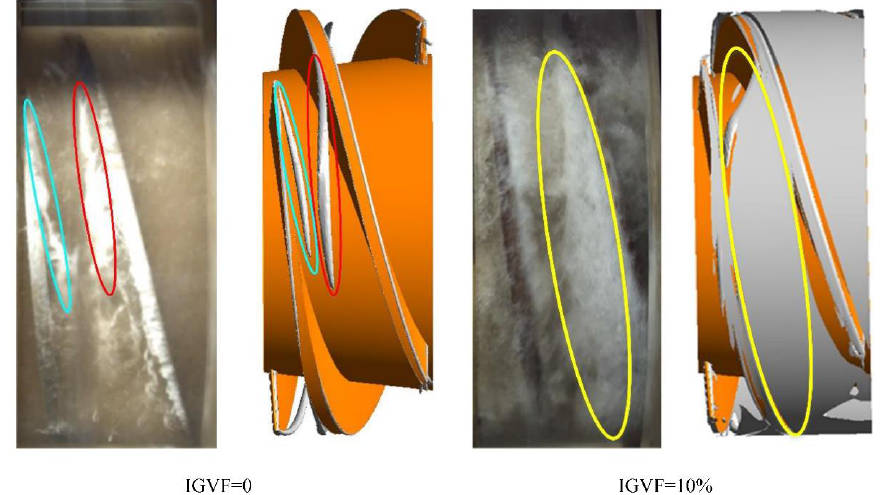
Figure 7. Experimental and computational fluid dynamic (CFD) flow patterns.